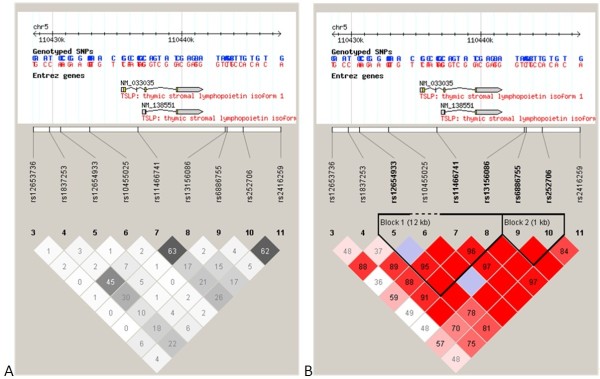
Graphical representation of the SNP locations and LD structure of the candidate gene. Each figure was composed of chromosome scale (the top line with even division), the transcription string (the thick bars represent exon (yellow) or UTR (blue), the thin lines represent intron), SNP scale (the hollow bar with scales representing SNPs location), and graphic of LD (black-and-white) or block definition (flammulated). The measure of LD (D’) among all possible pairs of SNPs is shown graphically according to the shade of color (A), where white represents very low D’ and dark represents very high D’. The numbers in squares are D’ values (D’ x 100). The measure of LD (r2) among all possible pairs of SNPs is shown graphically according to the shade of color (B), where white represents very low r2 and scarlet represents very high r2. The numbers in squares are r2 values (r2 x 100).